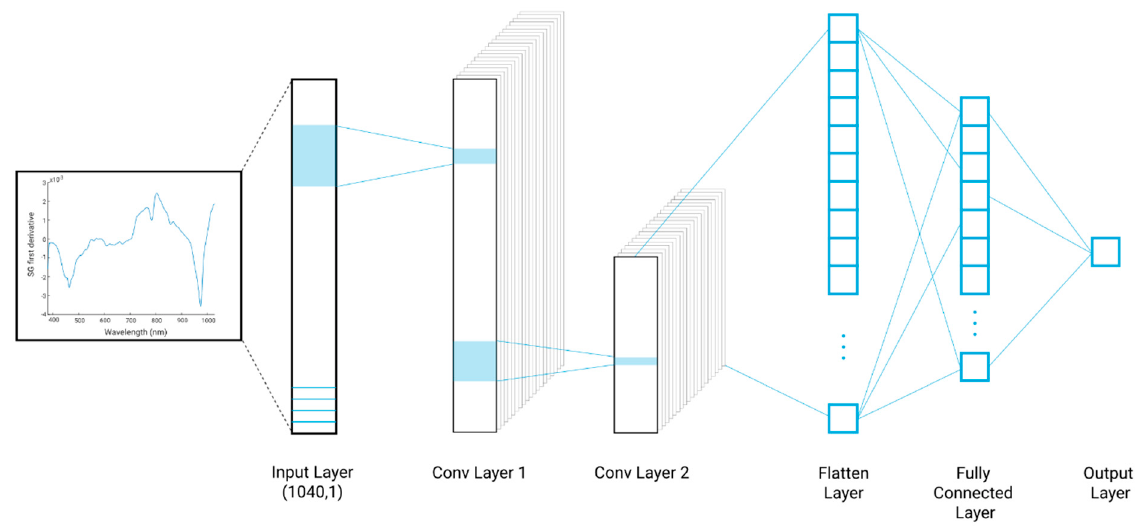
Figure 2. One − dimensional convolutional neural network architecture.